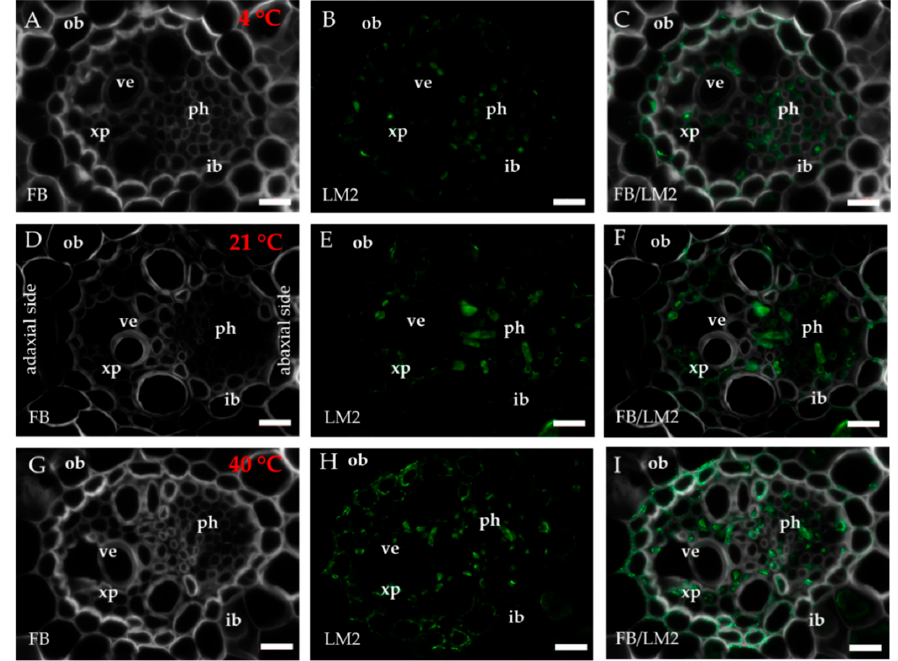
Figure 4. Immunolocalisation of the LM2 epitope ( A – I ) in cross ‐ sections of the B. distachyon leaves, ( A – I ): through the major vascular bundle. ( A – C ): 4 °C; ( D – F ): 21 °C; ( G – I ): 40 °C. Abbreviations: FB—fluorescent brightener, ib—inner bundle sheath, ob—outer bundle sheath, ph—phloem, ve—vessels, xp—xylem parenchyma. The green colour shows epitope occurrence. Scale bars: 10 μ m.